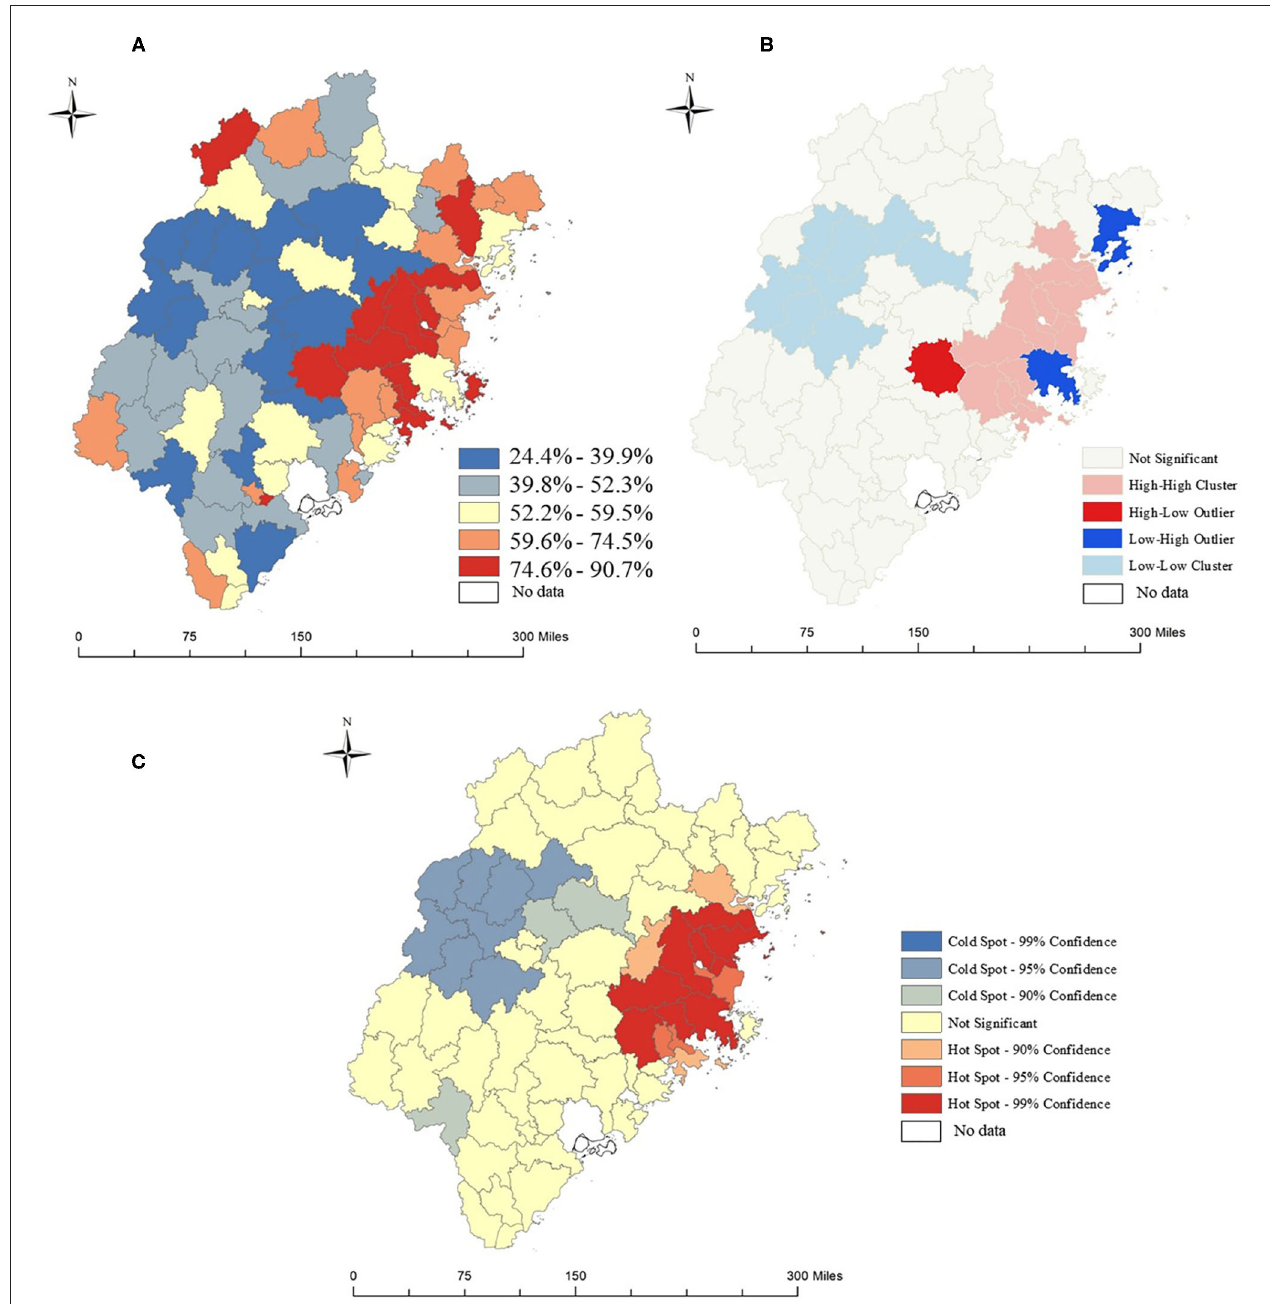
FIGURE 3 | Spatial analysis of CHE prevalence among rural elderly inpatients in southeast China, from 2010 to 2016. (A) The prevalence of rural elderly inpatients with CHE. (B) Anselin local Moran’s I analysis of the prevalence of rural elderly inpatients with CHE. (C) Hot spots analysis of the prevalence of rural elderly inpatients with